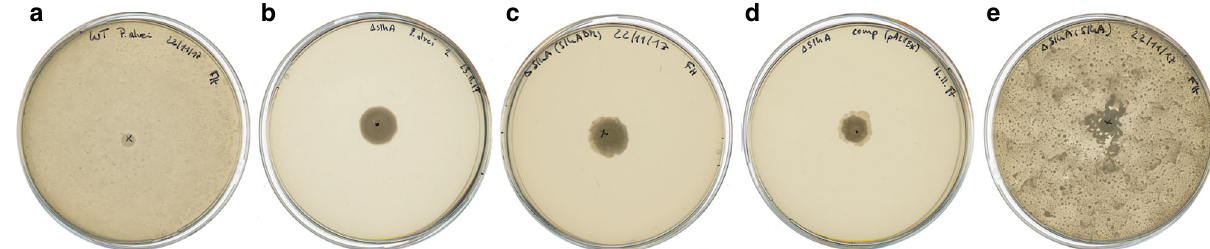
Fig. 6 Swarming motility of P. alvei CCM 2051 T variants. LB agar plates showing the growth of a P. alvei wt , b P. alvei Δ slhA , c P. alvei Δ slhA complemented with slhA/G1224A/G1293A , d P. alvei Δ slhA complemented with empty plasmid pEXALV, and e P. alvei Δ slhA complemented with